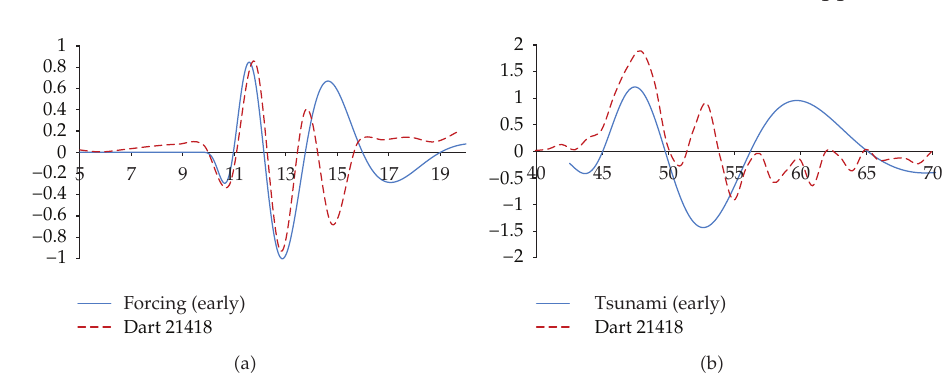
Figure 4: (cid:2) a (cid:3) Comparison of forcing from data (cid:2) dashed line (cid:3) and model (cid:2) solid line (cid:3) results in q (cid:5) 1 . 25; (cid:2) b (cid:3) comparing tsunami at DART 21418 and propagation model results in A (cid:5) 6 × 10 7